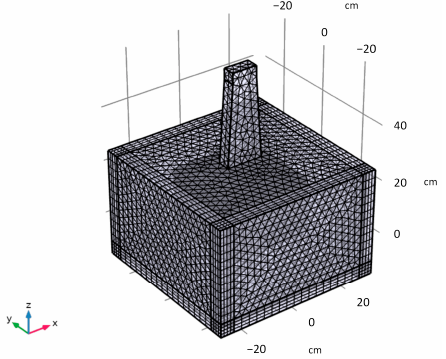
Figure 2. Meshing of the microwave irradiation simulation model. Table 1. Main parameter settings of microwave soil irradiation temperature field simulation.